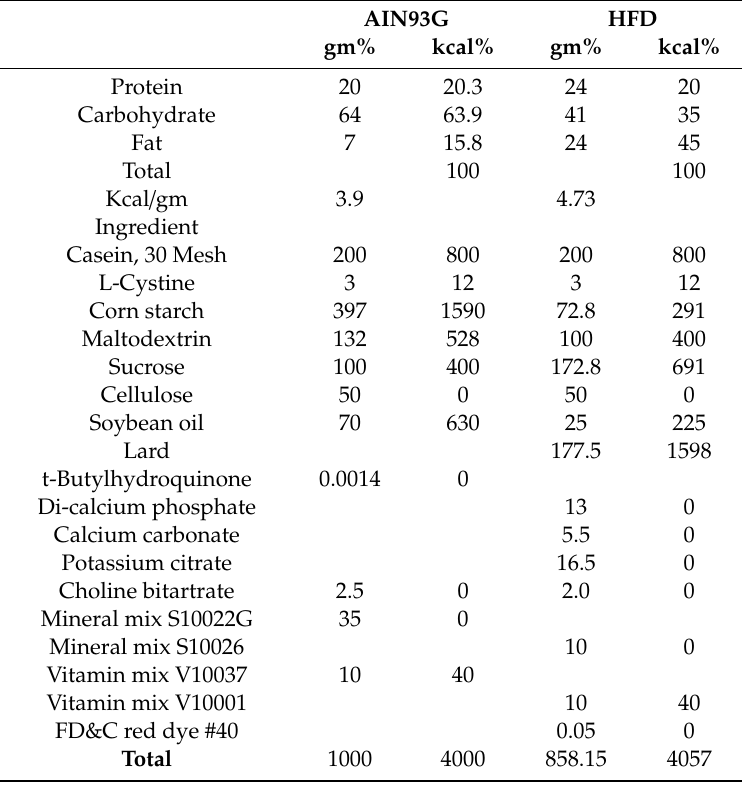
Table 1. Dietary compositions. Presented are the proportions of certain substances within the diet mixture in percentages based on mass (gm%) and kilo calories (kcal %). AIN93G (D10012G) and high fat diet (HFD, D12451) were produced by Research Diets, Inc., New Brunswick, USA.